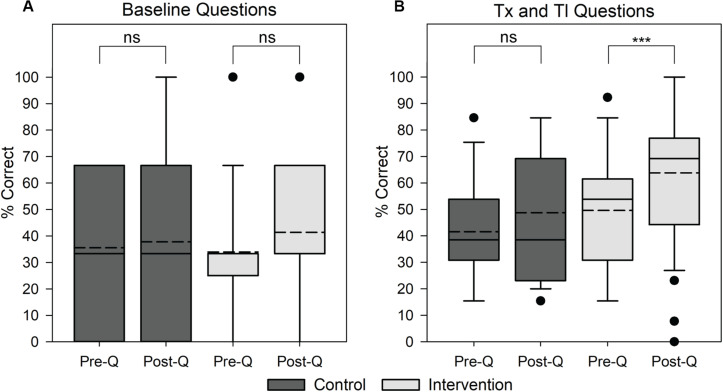
Impact of the Genetic Code Kit on student performance on content-based questions involving baseline or transcription (Tx) and translation (Tl) questions. Student score distributions are depicted as follow: solid lines indicate median, dotted lines indicate mean, boxes demarcate the 25th and 75th percentiles, whiskers represent the 10th and 90th percentiles, and points represent outliers. Control group scores represent a population of 15 students and intervention group scores represent a population of 54 students. The content-based portion of the questionnaire contained 16 questions, 3 baseline and 13 transcription and translation. Specific questions can be found in Supplementary Data Sheet 4. (A) Student score distributions for baseline questions. Pre- and post- scores for the control group and intervention group were compared using a two-sided paired t-test (ns indicates p-value > 0.05) with a null hypothesis that pre- and post- scores will be equal. (B) Student score distributions for transcription and translation questions. Pre- and post- scores for the control group and intervention group were compared using a one-sided paired t-test (ns indicates p-value > 0.05, *** indicates p-value < 0.001) with a null hypothesis that pre- and post- scores will be equal.